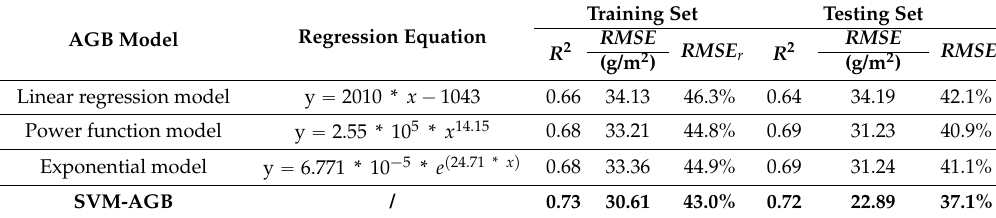
Table 6. Comparison of the accuracy of different AGB estimation models based on MODIS NDVI.